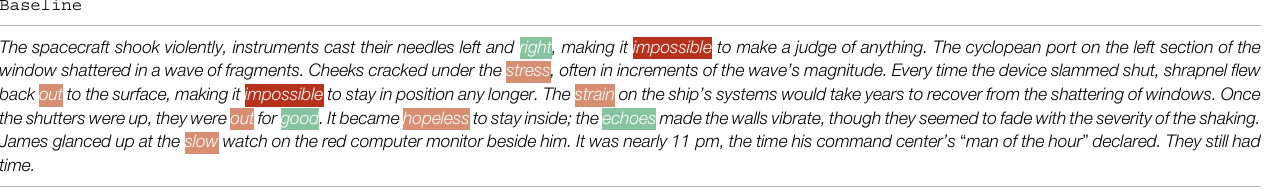
TABLE 17 | Example stories generated with Very negative sentiment